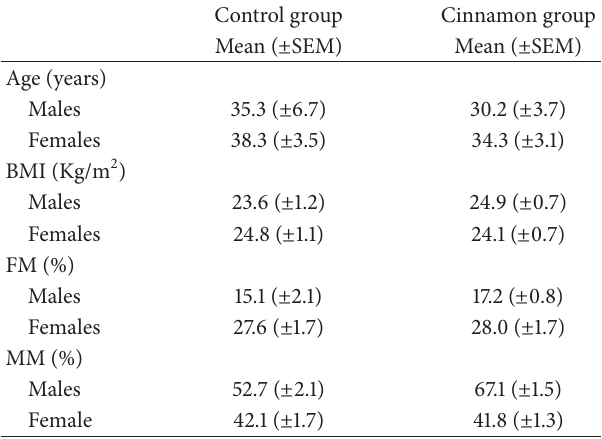
Table 1: Characteristics of the study participants ( 𝑛 = 30 ). Data represented mean ( ± SEM).